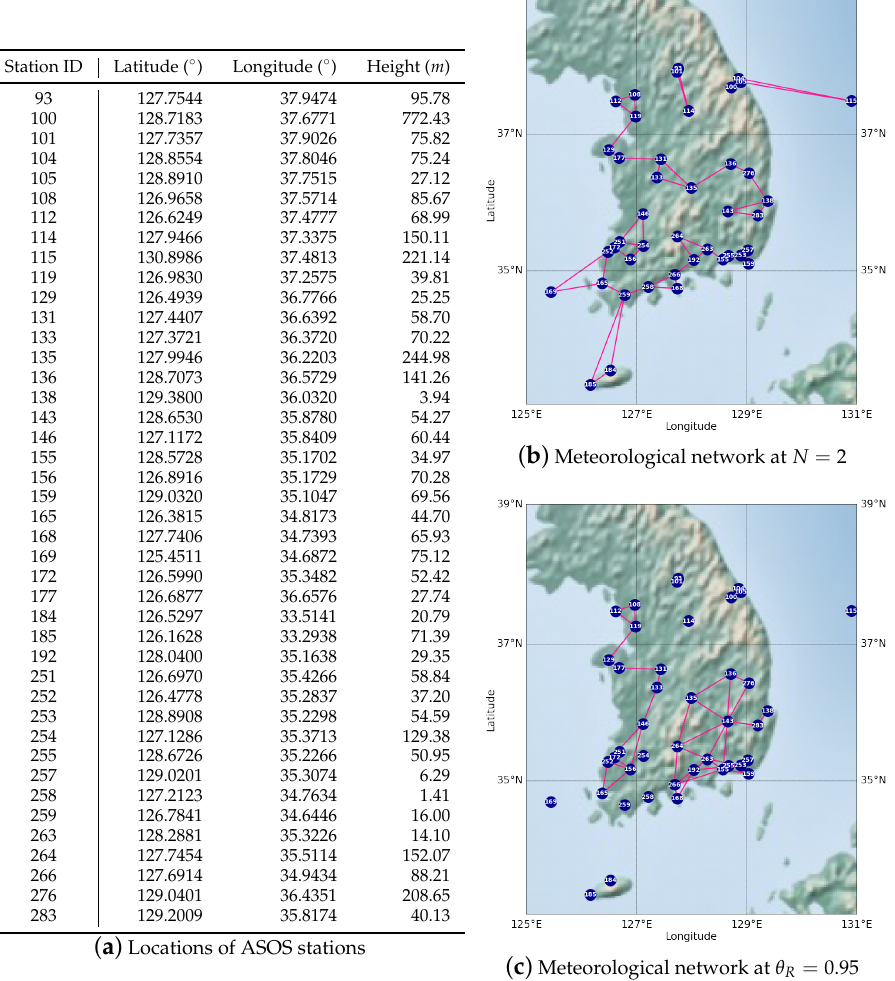
Figure 1. Information of automated surface observing systems (ASOS) stations and examples of meteorological networks. ( a ) presents geographic coordinates of ASOS stations. ( b , c ) show meteoro- logical networks composed based on geographical distances between the ASOS stations and based on correlations between historical solar irradiance of the stations, respectively. N indicates the number of neighboring stations, and θ R denotes the threshold of correlations between solar irradiance